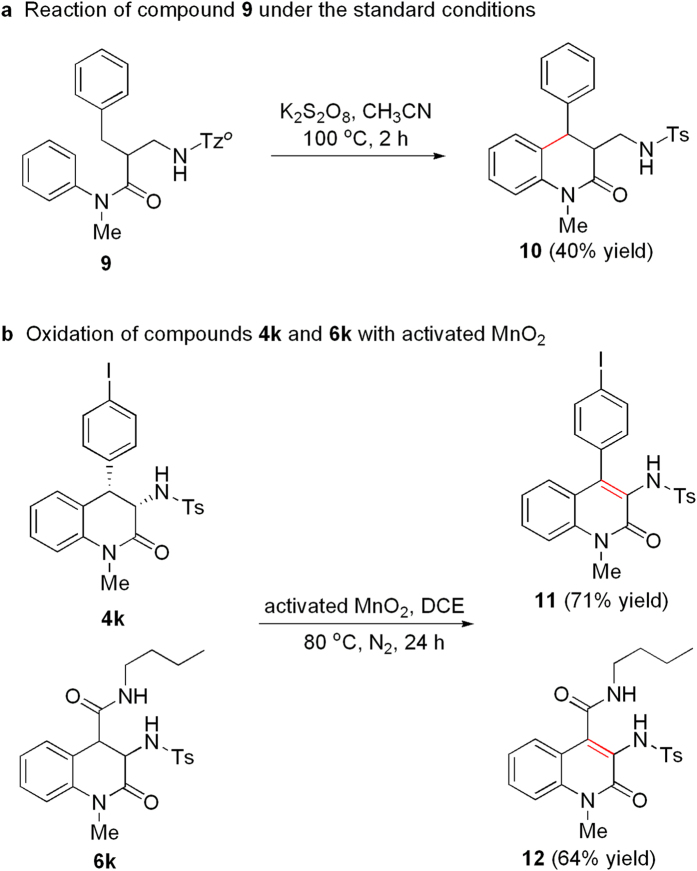
Application of the methods.(a) Treatment of compound 9 under the standard conditions. (b) Oxidation of compounds 4k and 6k with activated MnO2.